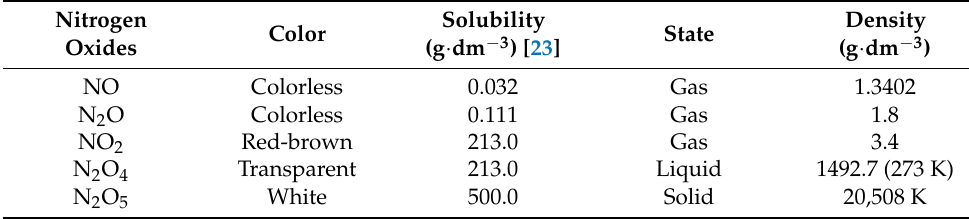
Table 2. The most common existing nitrogen oxides and their physical properties of these oxides are given. Adapted with permission from [22]. Copyright, 2010